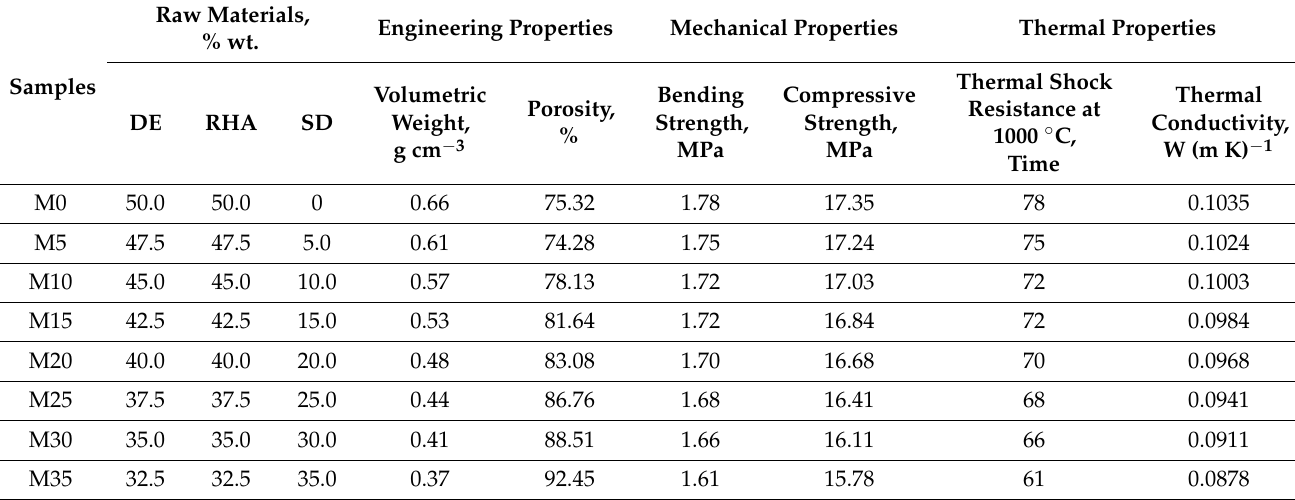
Table 1. Composition and properties of porous DE/RHA/SD-based refractory. Data from